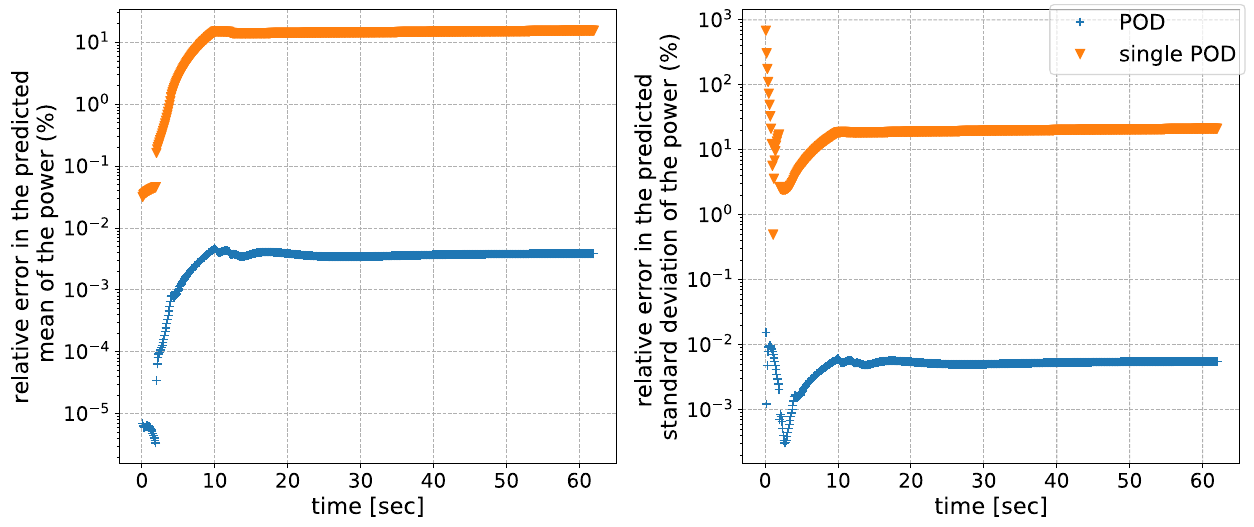
Figure 3: Relative errors in power mean and standard deviation prediction